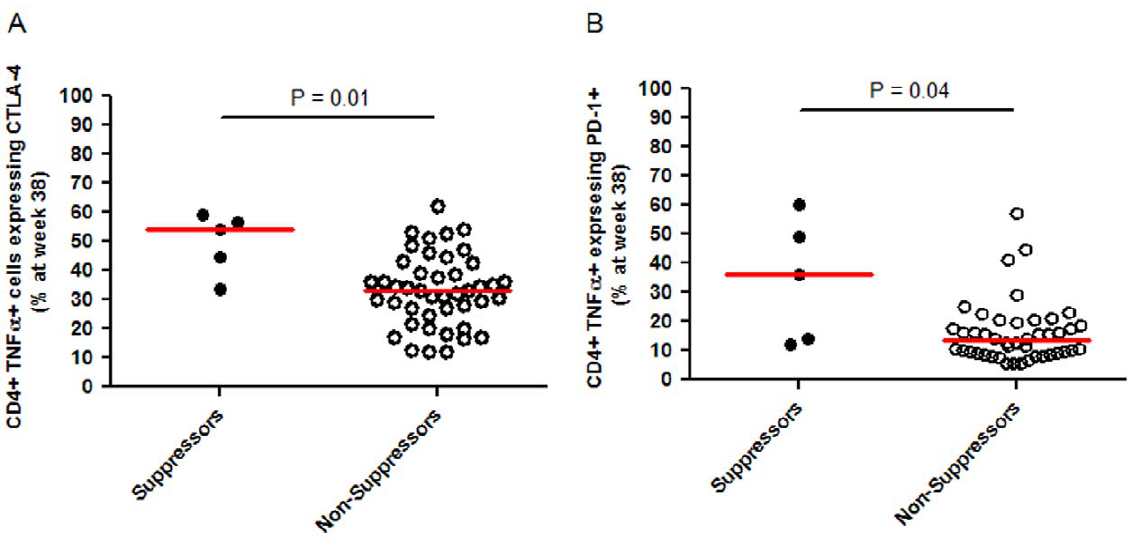
Figure 4. Expression of HIV-1 Gag-specific CD4 + TNF- a + T cells expressing either CTLA-4 + or PD-1 + by participants with and without initial virologic suppression. Panel A, Percentage of CD4 + TNF- a + T cells expressing CTLA-4 at week 38. Panel B, Percentage of CD4 + TNF- a + T cells expressing PD-1 at week 38.